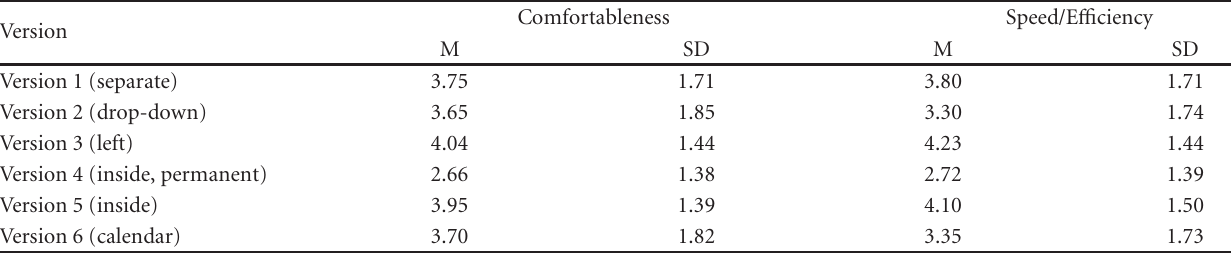
Table 3: Subjective evaluation of the six versions.